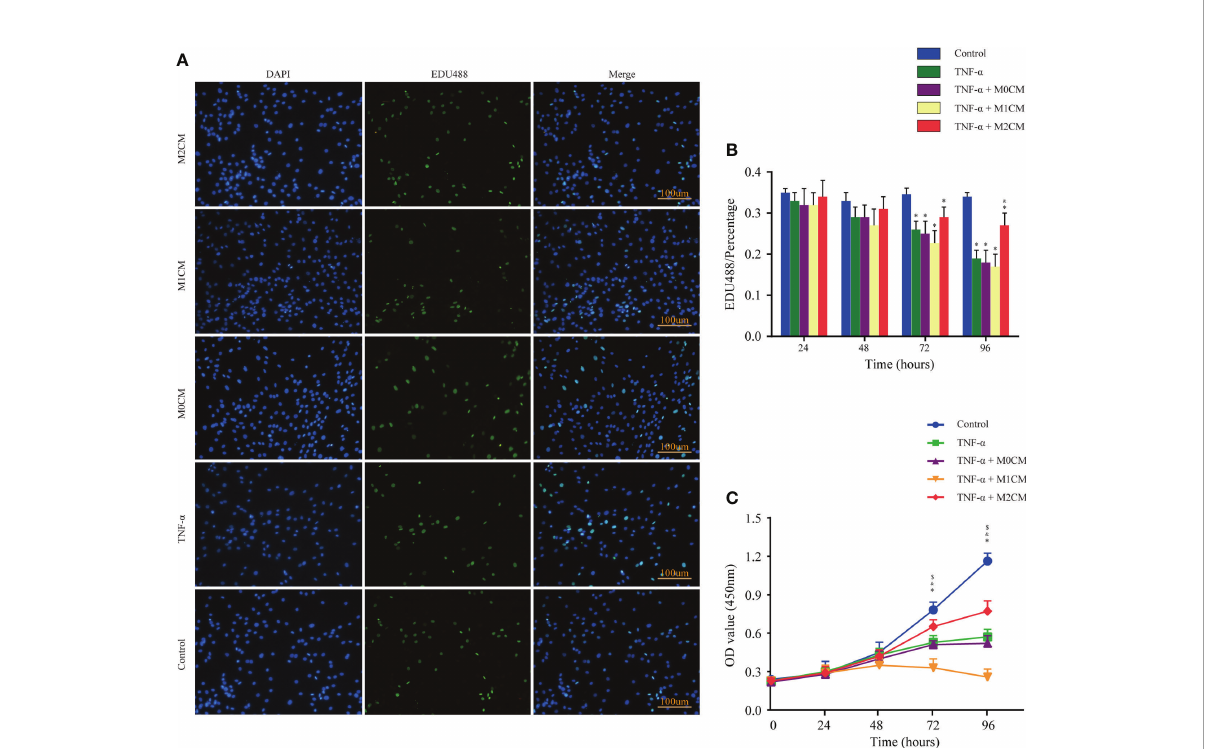
FIGURE 2 | Effect of macrophage polarization on the proliferation of NPCs in the TNF- a -treated environment. (A) Representative images showing EDU incorporation staining of NPCs in different groups. (B) Comparison of EDU positive staining ratios corresponding to different test compounds at different time points. (C) Comparison of OD values corresponding to different test compounds at different time points based on cell proliferation assays. Data are expressed as the mean ± SD (n = 4). *, signi fi cant difference between the control and TNF- a -treated groups at P < 0.05; $ , signi fi cant difference between the TNF- a - and M1CM+ TNF- a -treated groups at P < 0.05; & , signi fi cant difference between the TNF- a - and M2CM+ TNF- a -treated groups at P < 0.05. NPCs, nucleus pulposus cells; TNF- a , tumor necrosis factor- a